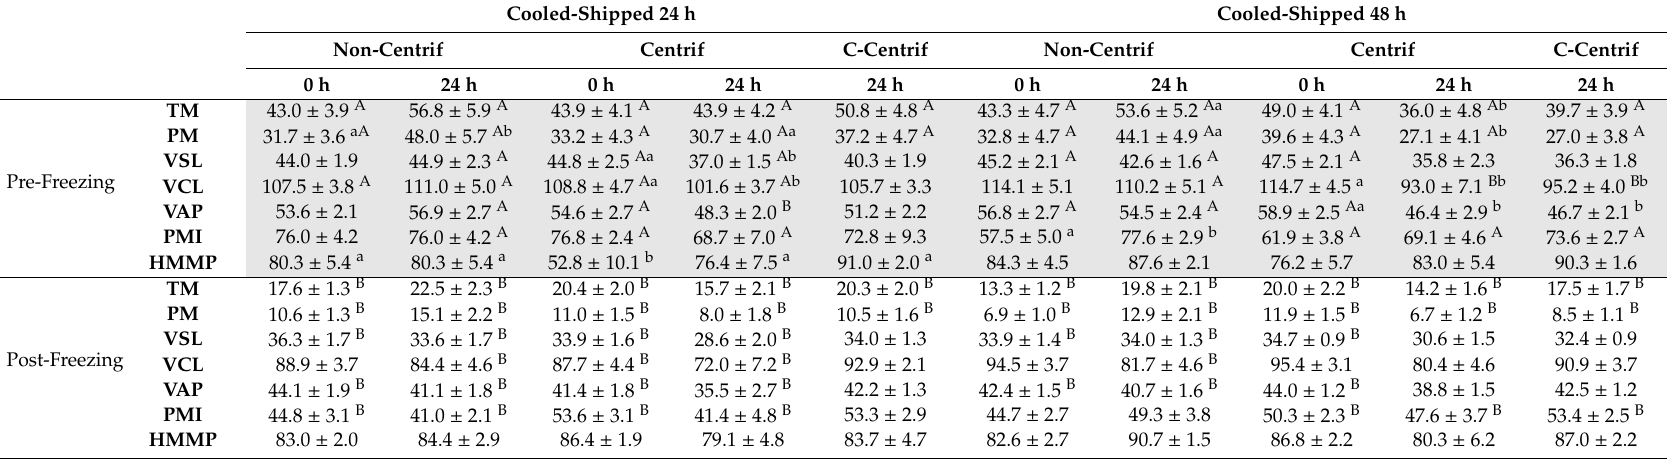
Table 6. Pre- and post-freezing parameters of the epididymal semen obtained from donkey cooled-shipped epididymides ( cooled-shipped 24 h ) dissected from the testes. All epididymides were kept in the passive cooling device until processing. The epididymides were processed upon arrival ( n = 20 pairs, cooled-shipped 24 h ) or the following day post-arrival ( n = 16 pairs, cooled-shipped 48 h ). Each epididymal pair was submitted to retrograde flushing with a semen freezing egg yolk-based extender (EY), or a cooling extender based on sodium caseinate cholesterol-loaded cyclodextrin (SC). Thereafter, the semen extended in EY was frozen immediately after recovery ( Non-Centrif-0 h ) or cooled for 24 h and then frozen ( Non-Centrif-24 h ). The semen extended in SC was cushion-centrifuged, resuspended in EY and then frozen ( Centrif-0 h ); or cooled for 24 h before being frozen ( Centrif-24 h ); or cushion-centrifuged, re-extended with SC, and then cooled for 24 h, re-centrifuged and extended in EY and then frozen ( C-Centrif-24 h ). Data are expressed as the mean ±